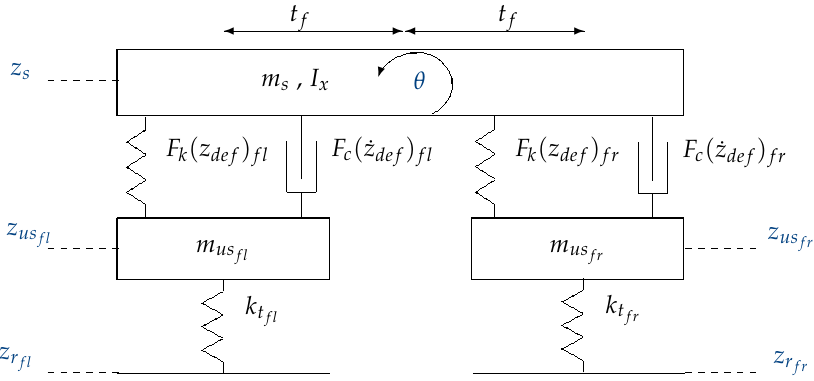
Figure 4. Half car suspension model (roll oriented).